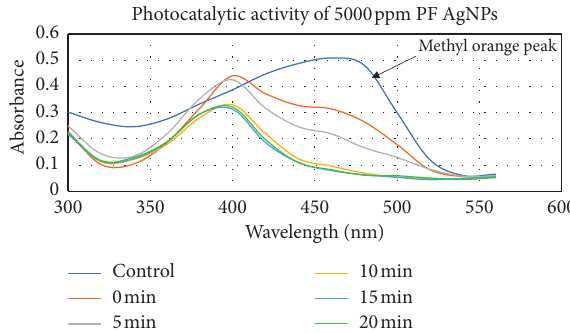
Figure 26: Absorbance of methyl orange with time when 5000ppm PF AgNPs were added.